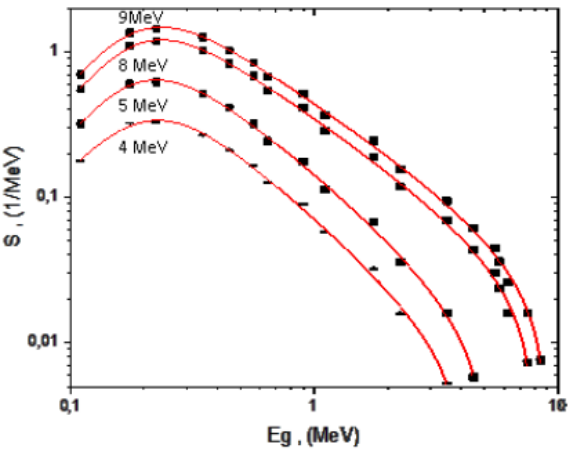
Fig. 4. The simulated bremsstrahlung for different electron beam energies 4, 5, 8 and 9 MeV. It should be noted that the bremsstrahlung spectrum depends on both the electron energy and the thickness of the braking target and its atomic composition. The penetration depth of a monoenergetic electron beam with energies 3 < E e <20 MeV